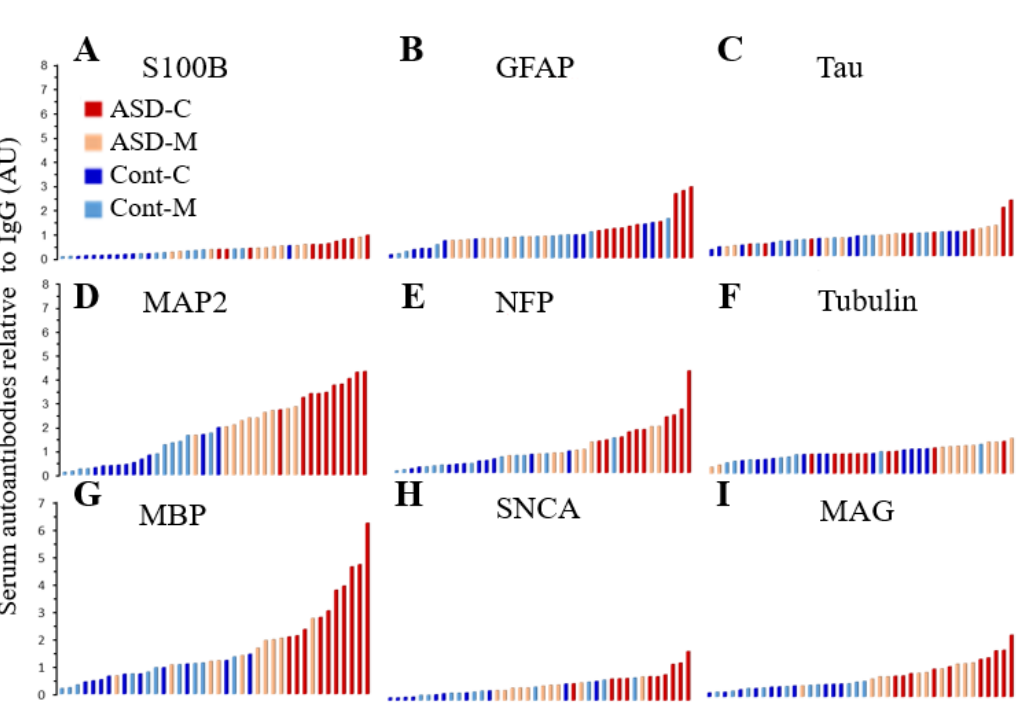
Figure 4 Figure 4. Histogram representing the profiles of individual levels of serum autoantibodies in ASD children (ASD-C) represented in red color bars; ASD children’s mothers (ASD-M) represented in light rose color bars; Control children (Cont-C) represented in royal blue color bars and Control children’s mothers (Cont-M) represented in light blue color bars. ( A ) S100B; ( B ) GFAP; ( C ) Tau; ( D ) MAP2; ( E ) NFP; ( F ) Tubulin; ( G ) MBP; ( H ) SNCA and ( I )